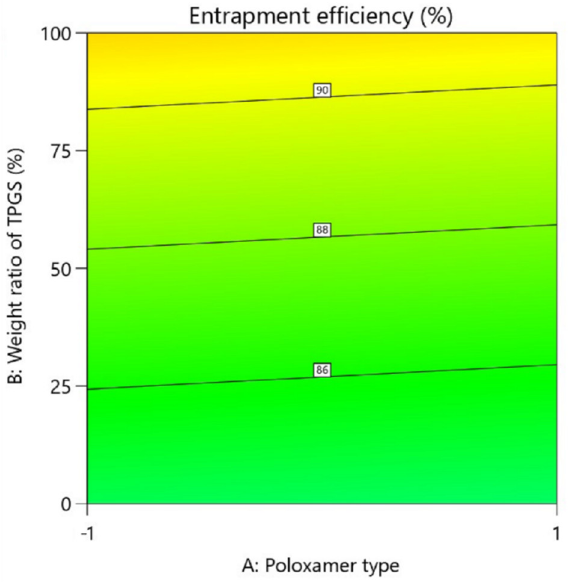
Figure 3. Contour plot showing relative effect of poloxamer type and weight ratio of TPGS on entrapment efficiency.